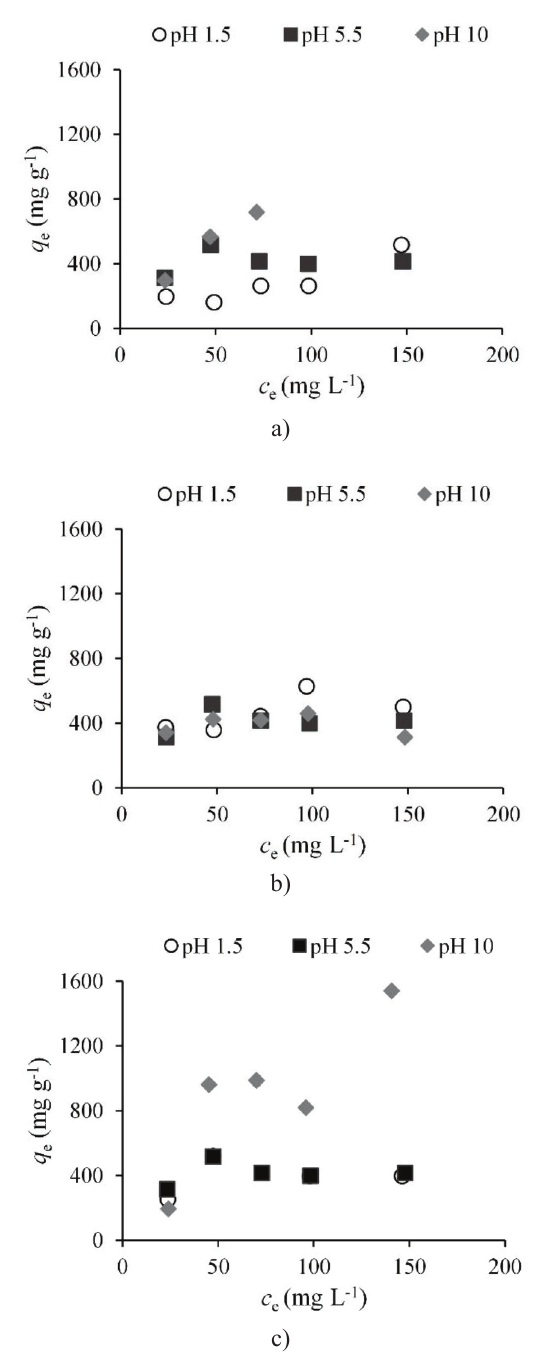
Fig. 2 – Data for adsorption isotherms (q 25, 37, and 45 °C (pH 5.5). Data shown are means ± standard deviation of means. a) p-coumaric acid; b) caffeic acid; c) chlorogenic acid.